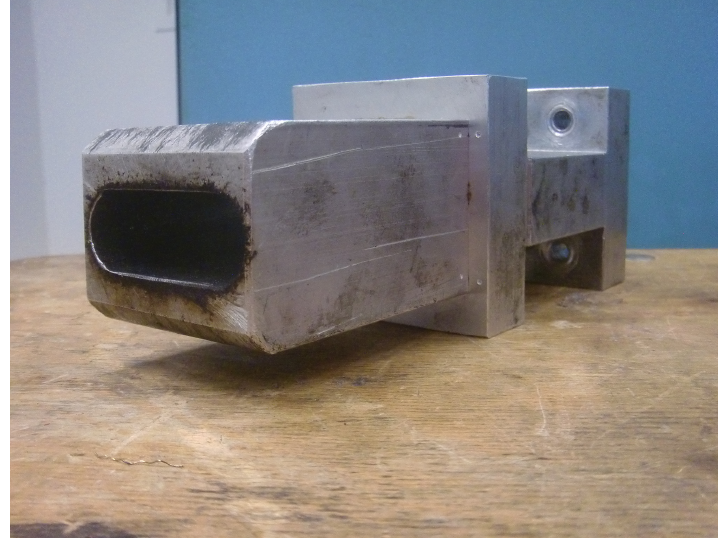
Figure 3. Elongated die.